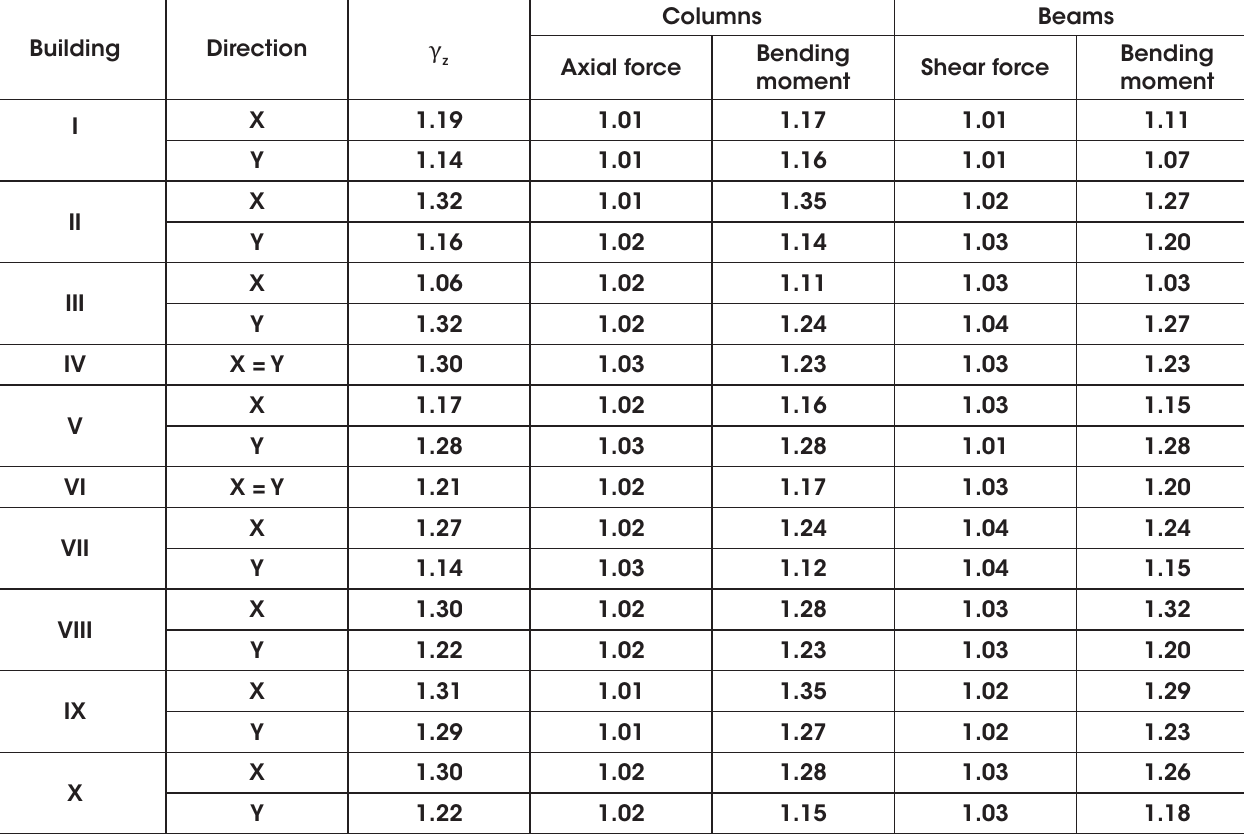
coefficients and average values of ratio (second order effort / first order effort) z γ